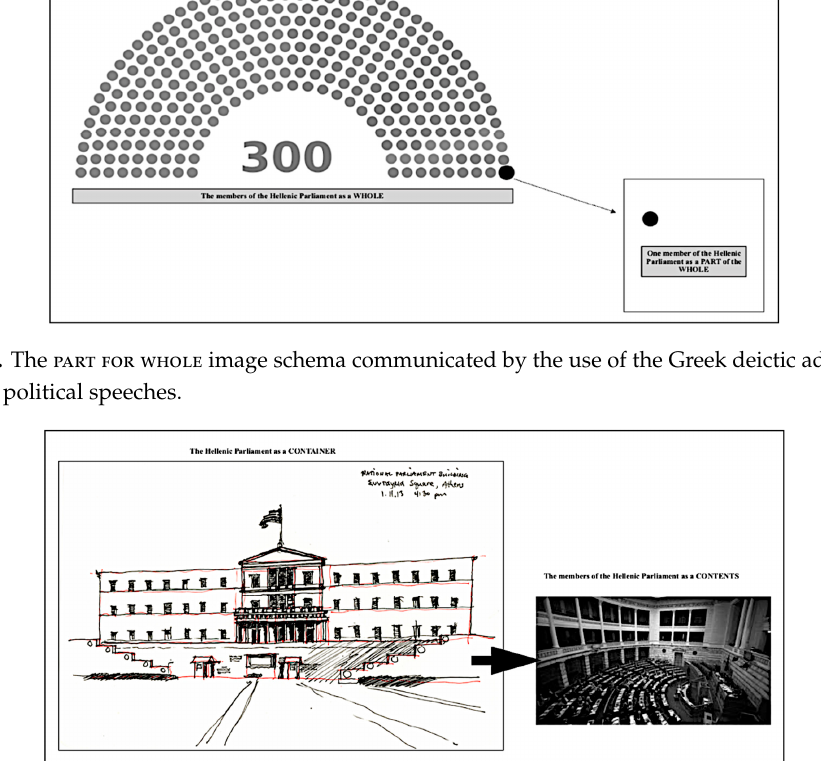
Figure 2. The CONTAINMENT image schema communicated by the use of the Greek deictic adverb εδώ [here] in political speeches.